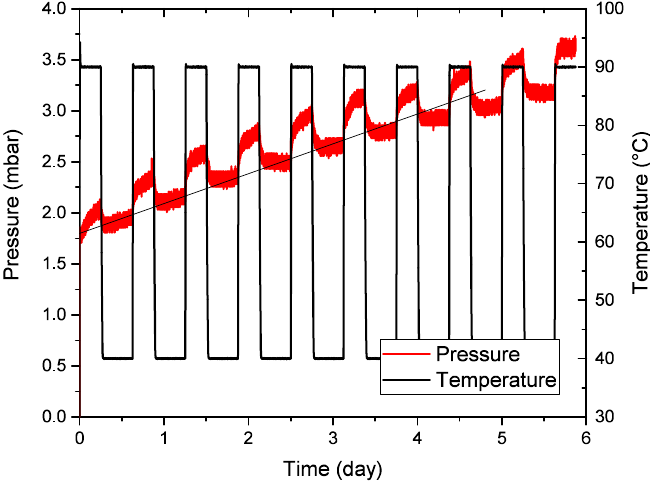
Figure 2. Pressure during leakage test. The period is because the temperature jumps between 40 and 90 ◦ C. The higher pressures are at 90 ◦ C, the lower at 40 ◦